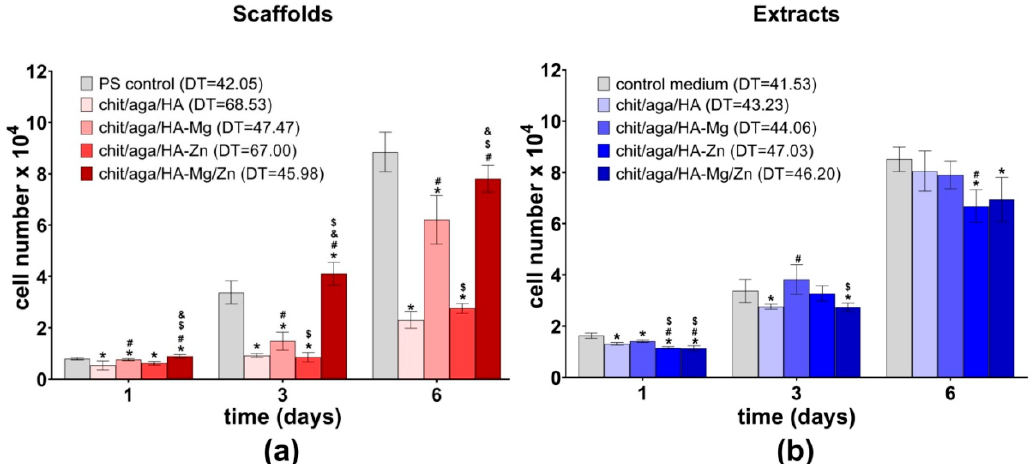
Figure 6. MC3T3-E1 cell proliferation analysis: ( a ) osteoblasts cultured on the surface of the scaffolds (PS control, cells cultured in the PS well of 96-multiwell plate) and ( b ) osteoblasts cultured in the PS wells in the presence of scaffolds extracts (control medium, cells maintained in culture medium). DT, doubling time in hours; * statistically significant results as compared to control; # statistically significant results as compared to chit / aga / HA; $ statistically significant results as compared to chit / aga / HA-Mg; & statistically significant results as compared to chit / aga / HA-Zn; P < 0.05, one-way ANOVA followed by Tukey’s test.